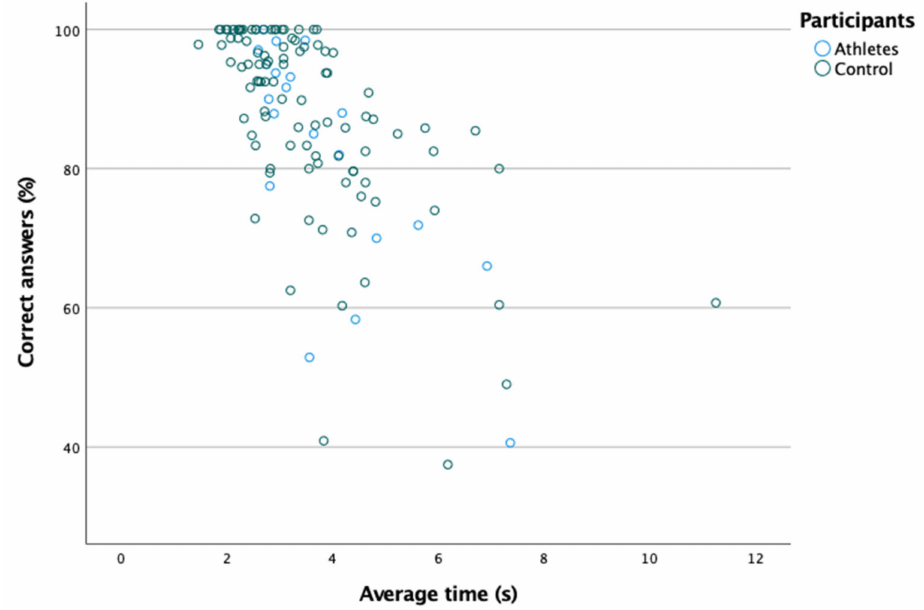
Figure 5. Negative linear relationship between the percentage of correct answers and the average